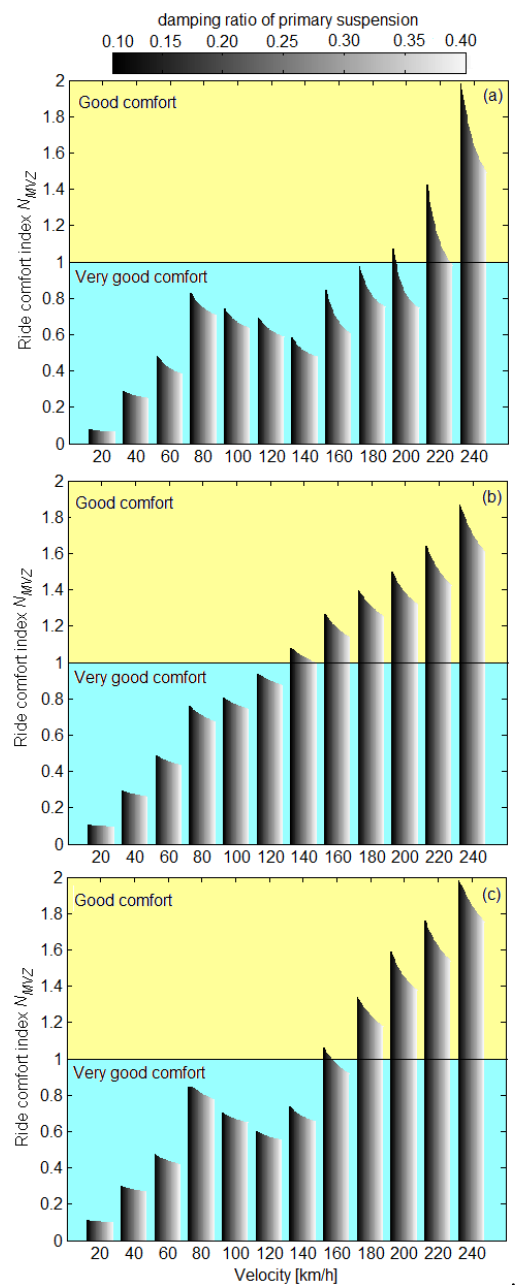
Figure 17. Ride comfort index N MVZ depending on the damping ratio of primary suspension: ( a ) in point C ; ( b ) in point B 1 ; ( c ) in point B 2 .